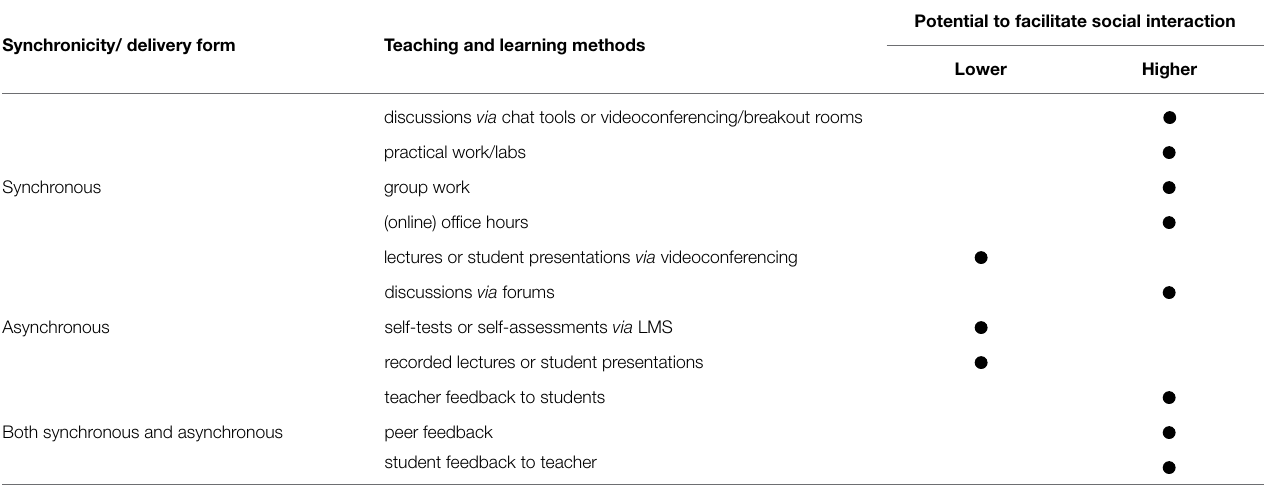
TABLE 2 | Classification of teaching and learning methods classified regarding their synchronicity and potential to facilitate social interaction.